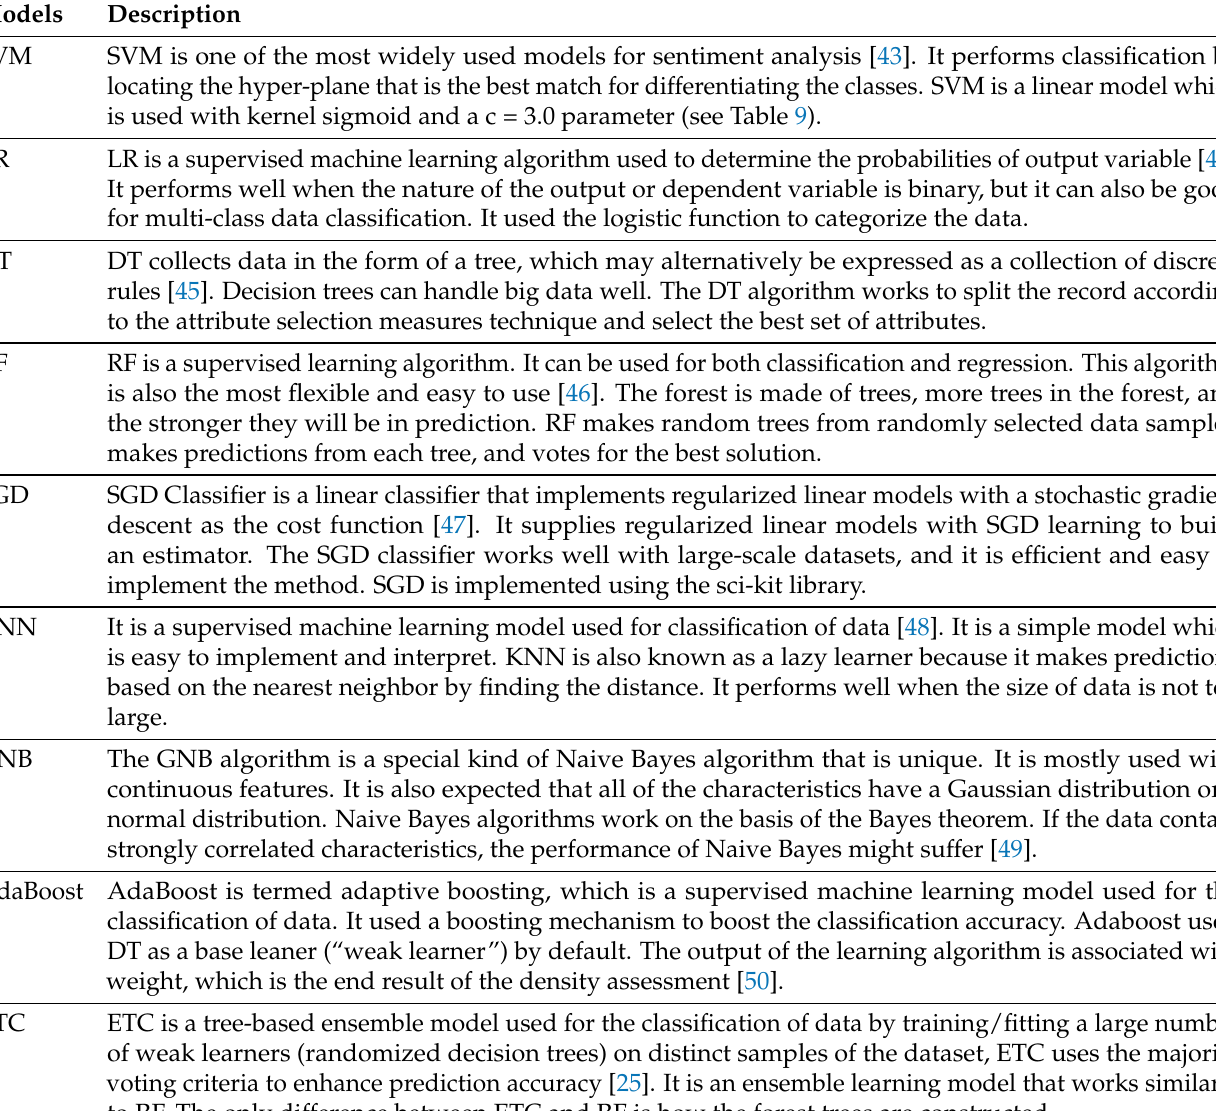
Table 8. Brief description of machine learning models used in this study.